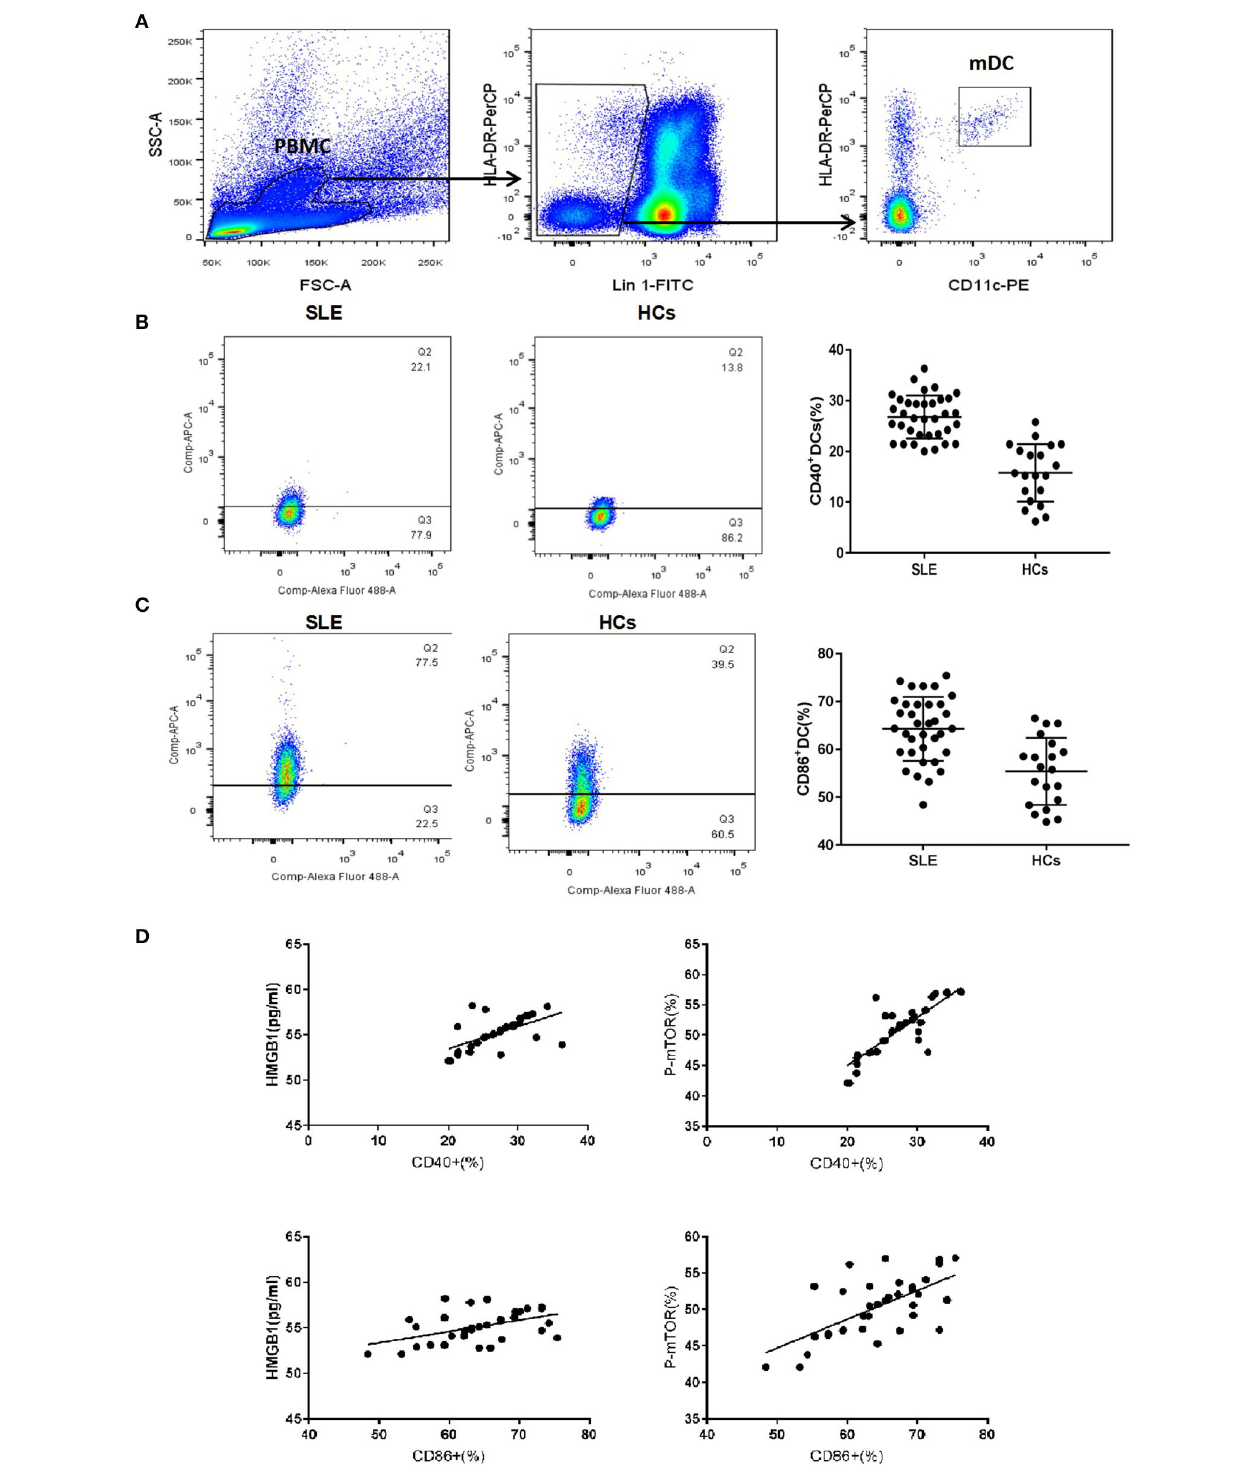
FIGURE 1 | mDCs phenotype of SLE and healthy control group. (A) Gating strategy for flow cytometry analysis of mDCs. (B) The mDC in peripheral blood of SLE patients to express more CD40 than HCs (26.79 ± 4.23% vs. 15.78 ± 5.68%, t = 8.185, p = 0.000). (C) The mDC in peripheral blood of SLE patients to express more CD86 than HCs (64.27 ± 6.68% vs. 55.38 ± 7.01%, t = 4.664, p = 0.000). (D) The levels of CD40 and CD86 were positively correlated with the levels of HMGB1 (CD40: r = 0.600, P = 0.001; CD86: r = 0.478, P = 0.004) and p-mTOR in mDCs (CD40: r = 0.812, P = 0.001; CD86: r = 0.640, P = 0.001).